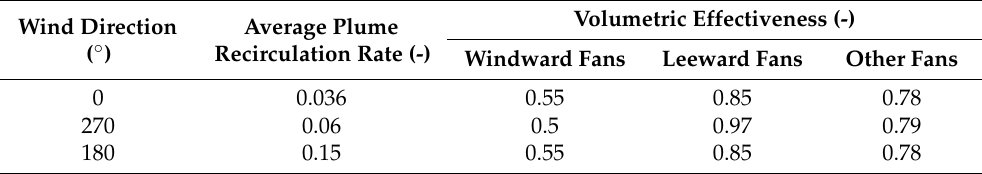
Table 2. The Parameters of Local Models. Wind Direction Average Plume ( ◦ ) Recirculation Rate